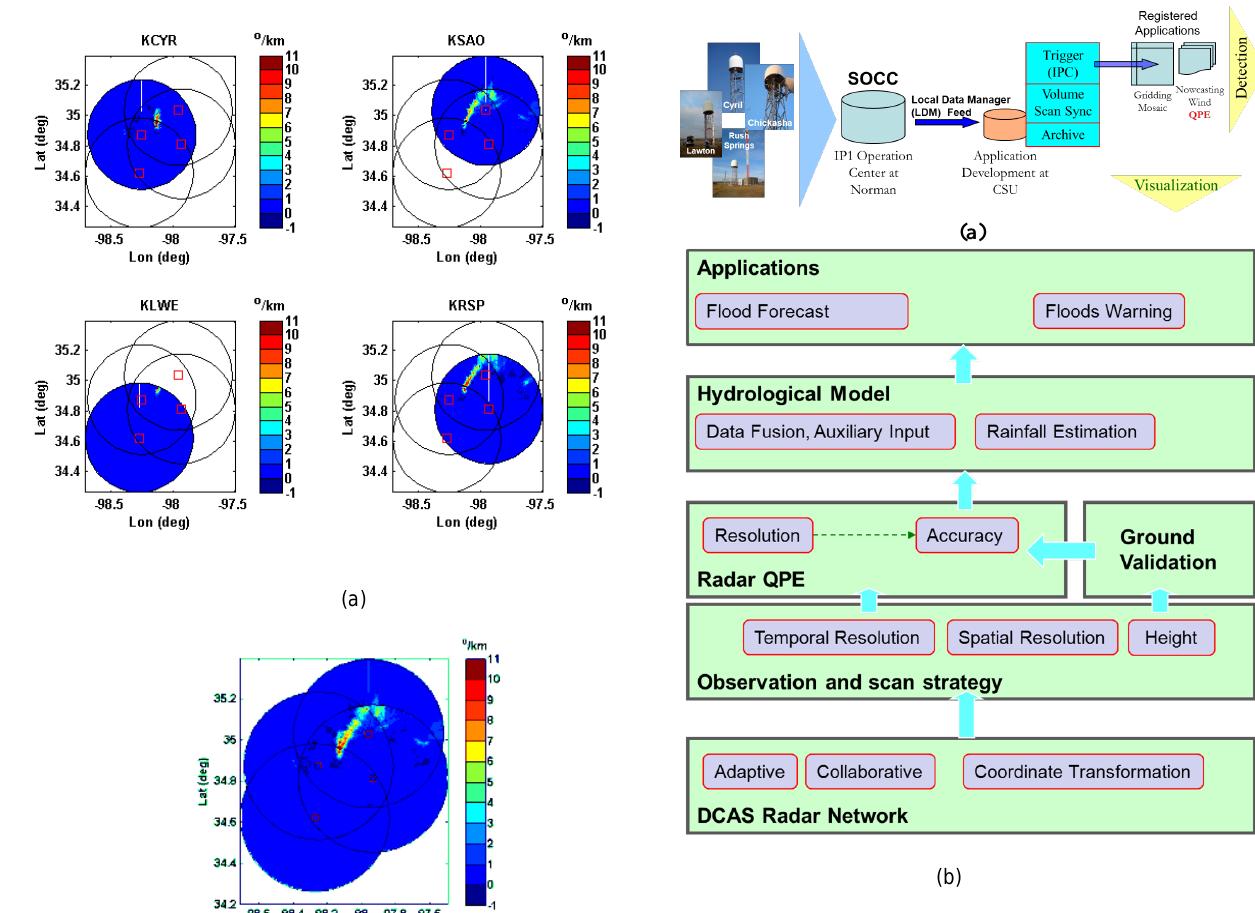
Fig.5. (a) Data Flow for QPE (b) Functional Architecture of urban floods monitoring system Fig. 5. (a) Data flow for QPE, (b) functional architecture of urban integrated into a DCAS radar network. floods monitoring system integrated into a DCAS radar Fig.4. Composite K dp estimates from the IP1 radar network, on 08:12 UTC, May 27, 2008. (a) Fig. 4. Composite K dp estimates from the IP1 radar network, on 08:12 UTC, 27 May 2008. (a) the estimated K dp field for each IP1 the estimated K dp field for each IP1 radar (b) the merged K dp field based on the data quality of radar, (b) the merged K dp field based on the data quality of K dp . K dp .